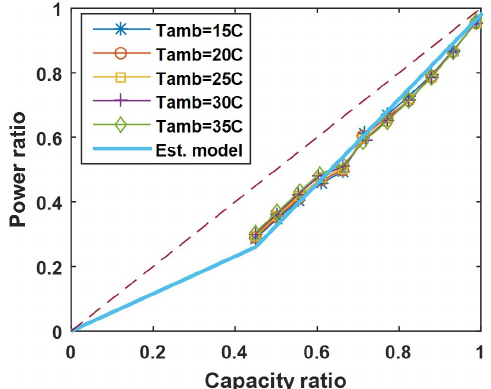
Figure 5. Variation of power ratio with capacity